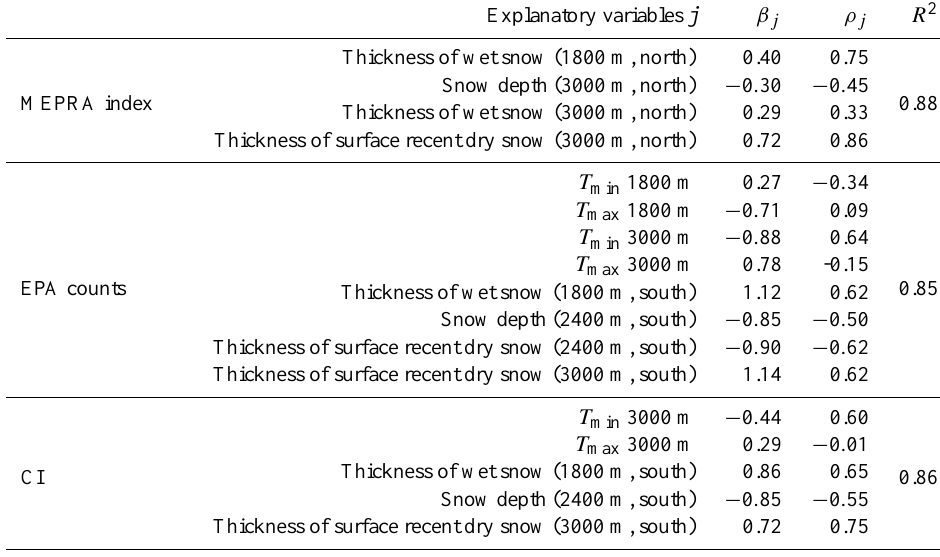
p P · β j + ε t at the French Alps scale for the annual anomalies in the three response variables X norm Table 3. Regression models y t = jt j = 1 (MEPRA index, EPA activity, and composite index CI). For each explanatory variable retained, X j , β j is the weighting coefficient, ρ j the .β j and the response variable, and R 2 the determination coefficient of the model. correlation coefficient between X norm jt